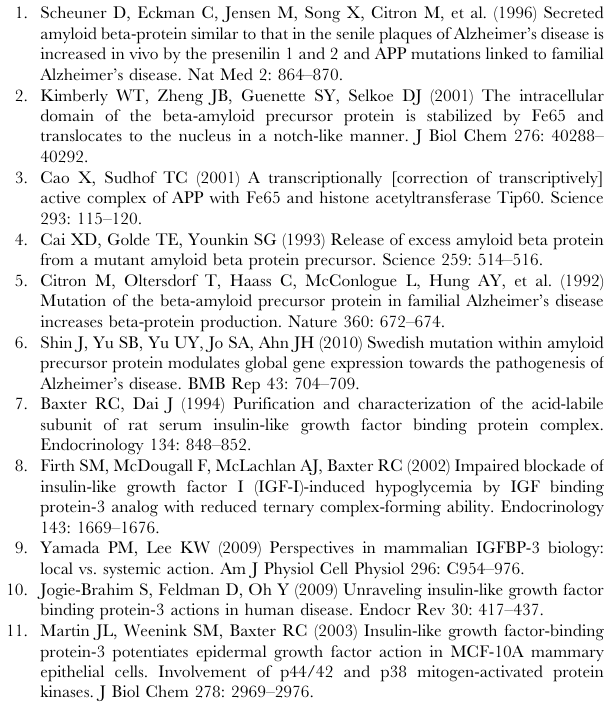
Figure S1 Native PAGE analysis of the aggregation states of A b 1–42 peptides freshly dissolved (A) or incubated at 4 6 C for 24 h (B). (TIF) Figure S2 The expression of beta-amyloid (A b ) in H4 and H4-sw cells. The secreted A b 1 – 40 and A b 1 – 42 peptides were determined by ELISA. Data are the means 6 standard deviation of triplicate experiments. (TIF) Figure S3 Endogenous Igfbp3 expression has not been altered by treatment of oligomeric A b 1–42 for 24h. Rat hippocampal neuronal primary cells in supplements-free media were treated for 24 h with or without 500 nM oligomeric A b 1 – 42 . After treatment with or without A b 1 – 42 , Igfbp3 mRNA expression was measured using qPCR (A). Igfbp3 protein expression was detected using western blot analyses. Representative results are illustrated and values from densitometric analyses after normali- zation to b -actin are reported relative to that of untreated controls (B). Data are shown as the mean 6 SD (n =3). (TIF) Supporting Information S1 Supplementary Materials and